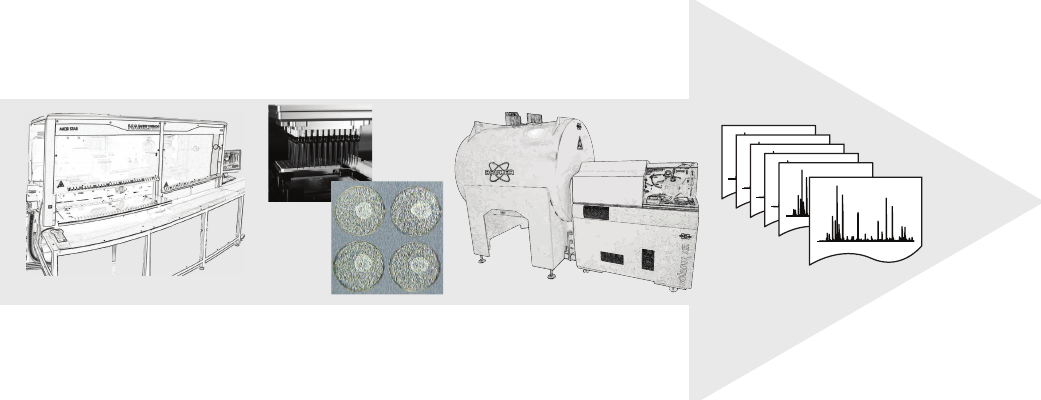
Figure 1: Peptides and proteins are isolated from body fluids using a fully automated solid-phase extraction protocol based on functionalized magnetic beads. All samples are processed in 96-well plate format with a 96-channel pipetting head, increasing throughput up to 1000 samples per 24 hours. After spotting onto a matrix-assisted laser desorption ionization (MALDI) target plate peptide and protein profiles are acquired on an ultrahigh resolution Fourier transform ion cyclotron resonance (FTICR)